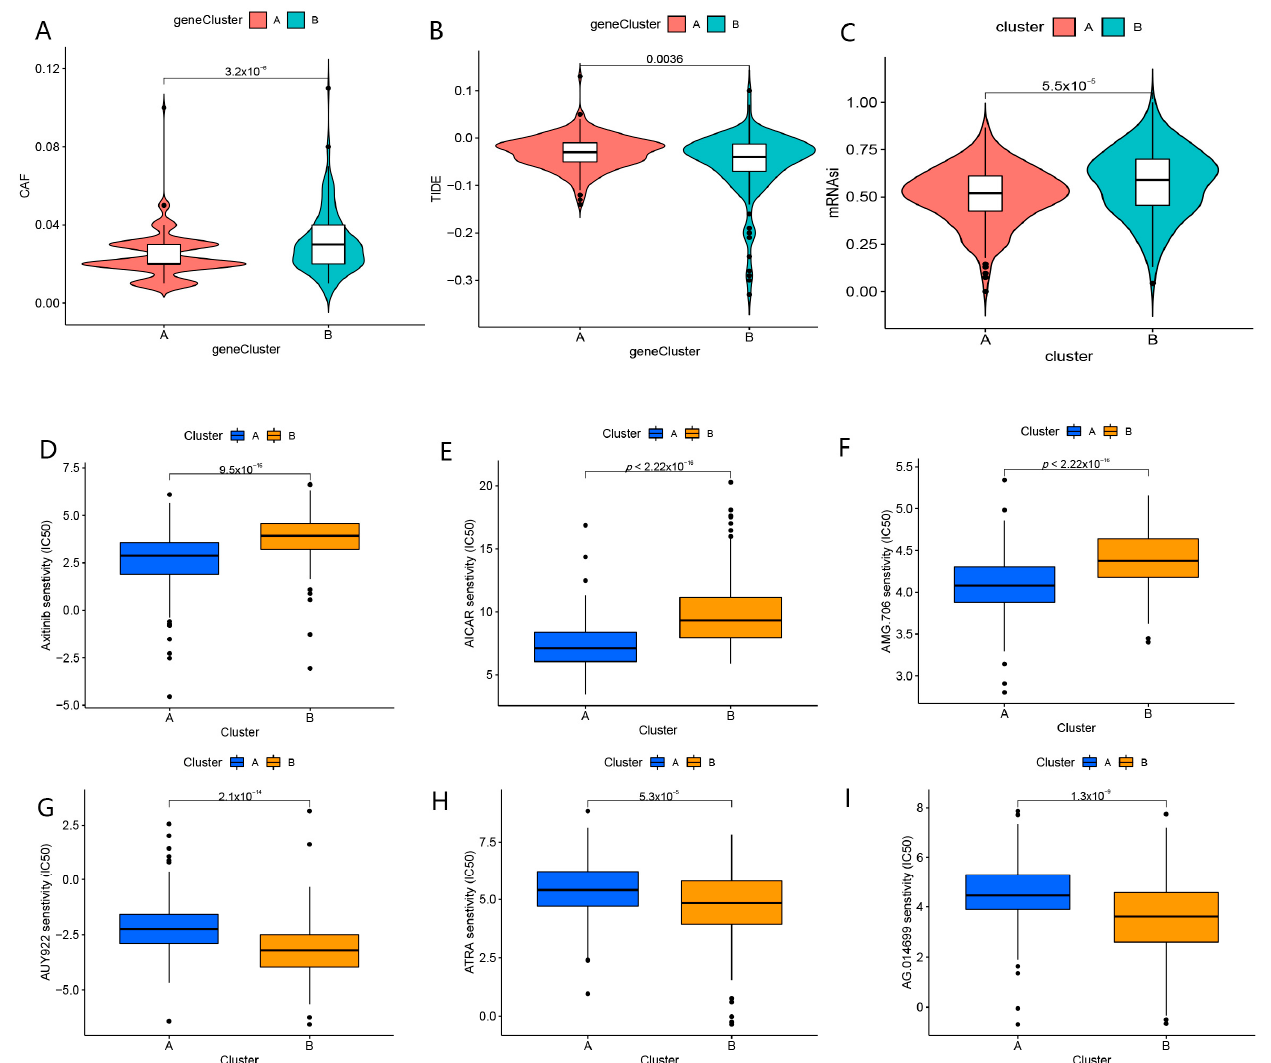
Figure 4. Responses to immunotherapy and drug sensitivity in distinct subtypes. ( A ) Comparison of CAF in clusters A and B. ( B ) Comparison of TIDE scores in clusters A and B. ( C ) Comparison of mRNAsi of immune checkpoint in cluster A and B. ( D ) Comparison of IC50 of Axitinib in clusters A and B. ( E ) Comparison of IC50 of AICAR in cluster A and B. ( F ) Comparison of IC50 of AMG.706 in clusters A and B. ( G ) Comparison of IC50 of AUY922 in clusters A and B. ( H ) Comparison of IC50 of ATRA in clusters A and B. ( I ) Comparison of IC50 of AG.014699 in clusters A and B.